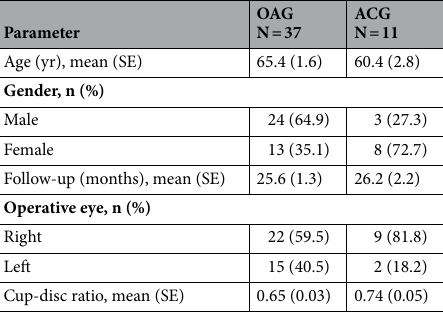
IOP outcomes. IOP data at each time point for the OAG group are given in Table 2 and Fig. 1. Among eyes with OAG, baseline IOP was 21.1 (0.9) mmHg and through up to 2 years of follow-up ranged from 13.6– 14.7 mmHg, representing absolute IOP reductions of 6.4–7.7 mmHg and relative reductions of 24.6–32.1% (p ≤ 0.0001 at all time points). At Month 24 (when 30/37 eyes were seen [81.1%]), mean IOP was 14.1 mmHg (a reduction of 7.7 mmHg [32.1%]; p < 0.0001). Across all time points, IOP reductions of ≥ 20% were achieved by 73.0–83.3% of eyes, IOP ≤ 18 mmHg by 89.2–97.3% of eyes, and IOP ≤ 15 mmHg by 72.9–83.9% of eyes; at Month 24, these secondary endpoints were achieved by 83.3%, 96.7%, and 73.3% of eyes, respectively (Table 4). IOP data at each time point for the ACG group are given in Table 3 and Fig. 1. Among eyes with ACG, baseline IOP was 20.8 (1.6) mmHg and through up to 2 years of follow-up ranged from 12.1–14.2 mmHg, representing absolute IOP reductions of 6.1–8.77 mmHg and relative reductions of 23.4–39.0% (p ≤ 0.0353 at all time points). At Month 24 (when 10/11 eyes were seen [90.1%]), mean IOP was 13.3 mmHg (a reduction of 7.9 mmHg [31.4%]; p = 0.0060). Across all time points, IOP reductions of ≥ 20% were achieved by 70.0–81.8% of eyes, IOP ≤ 18 mmHg by 90.9–100% of eyes, and IOP ≤ 15 mmHg by 70.0–90.9% of eyes; at Month 24, these secondary endpoints were achieved by 70%, 100%, and 70% of eyes, respectively (Table 4). Medication outcomes. IOP medication data at each time point for the OAG group are given in Table 2 and Fig. 2. Among eyes with OAG, the mean number of IOP medications at baseline was 3.3 (0.2) and through up to 2 years of follow-up ranged from 0.4–1.5, representing absolute reductions of 1.8–2.9 medications and relative reductions of 61.9–89.1% (p ≤ 0.0001 at all time points). At Month 24, the mean number of medications was 1.5 (a reduction of 1.9 [62.7%]; p < 0.0001). Across all time points, 81.8–100% of eyes were using fewer medications